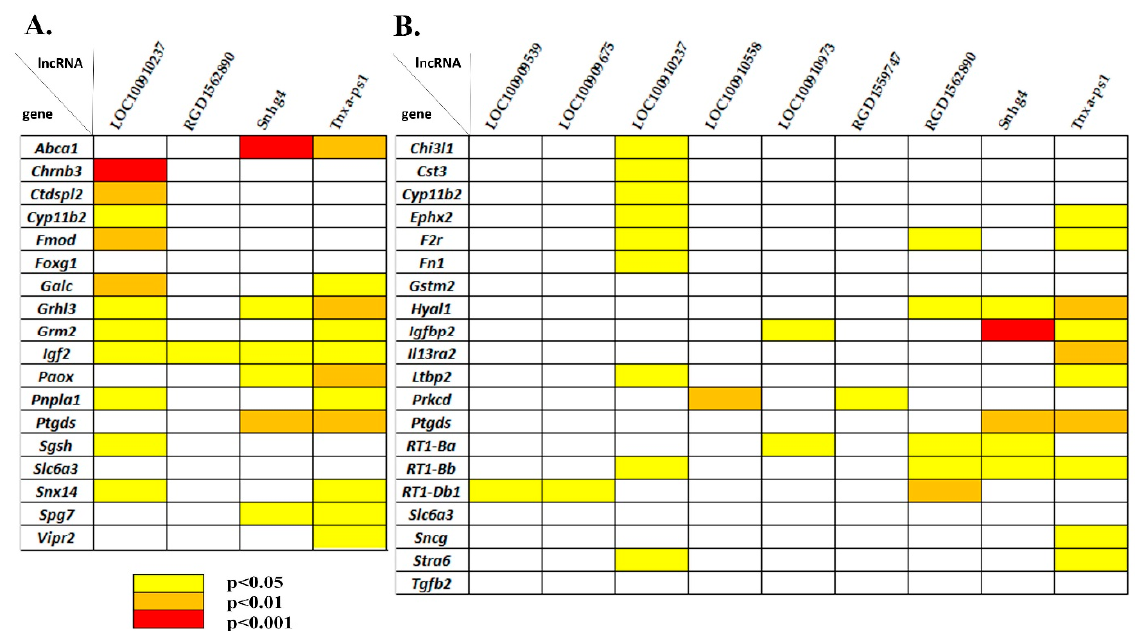
Figure 8. Correlation analysis of levels of expression between lncRNAs and DEGs associated with ( A ) the behavior/neurological phenotype or ( B ) hypertension. The greatest number of correlations was found between differentially expressed lncRNAs Snhg4, LOC100910237, RGD1562890 and Tnxa-ps1 and DEGs related to both the behavior/neurological phenotype and hypertension. The color indicates the levels of significance based on the two-tailed test (Pearson’s correlation analysis). Table 3. Hypothalamic DEGs associated with